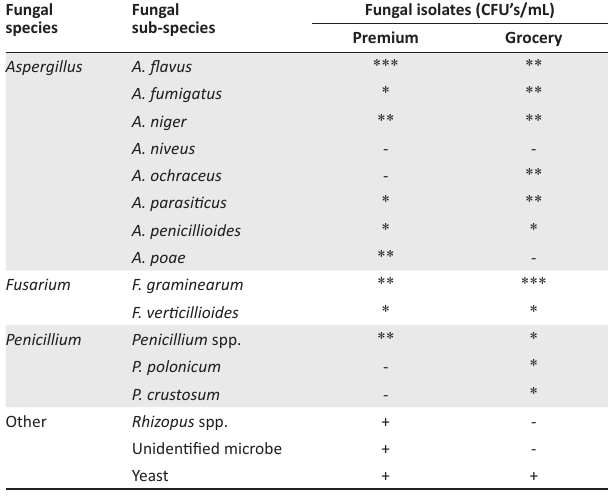
TABLE 2: Fungal species identification and selected mycotoxin detection in premium brand and grocery brand cat pelleted feed samples.